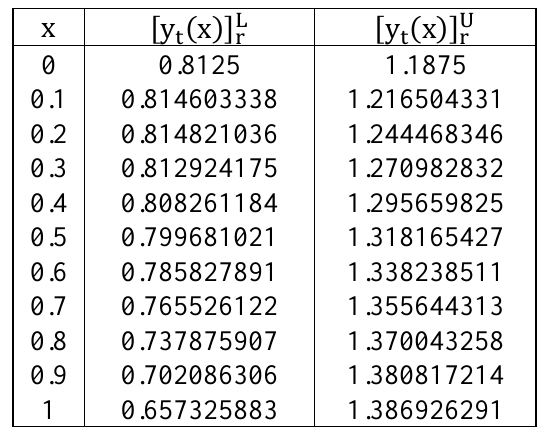
Table (3): Trial solutions for example (2), r =